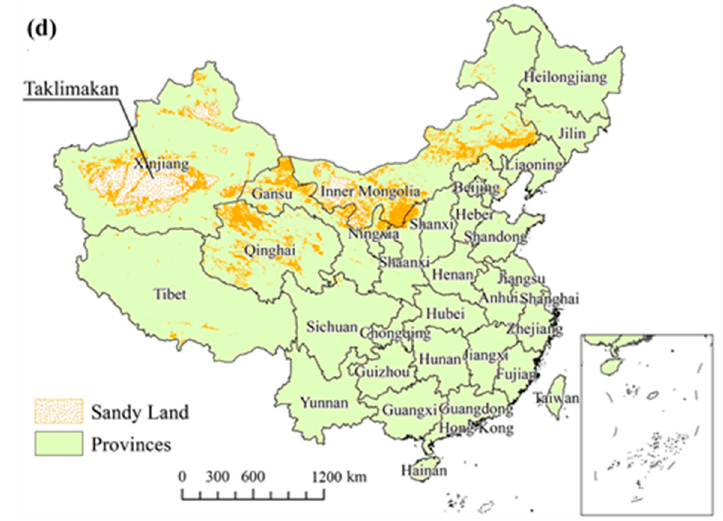
Figure 1. Spatial distribution of annual-averaged PM levels in Chinese mainland; ( a ) Spatial distribu- tion of PM 2.5 , ( b ) Spatial distribution of PM 10 , ( c ) Spatial distribution of PM 2.5 / PM 10 , and ( d ) Spatial distribution of sandy